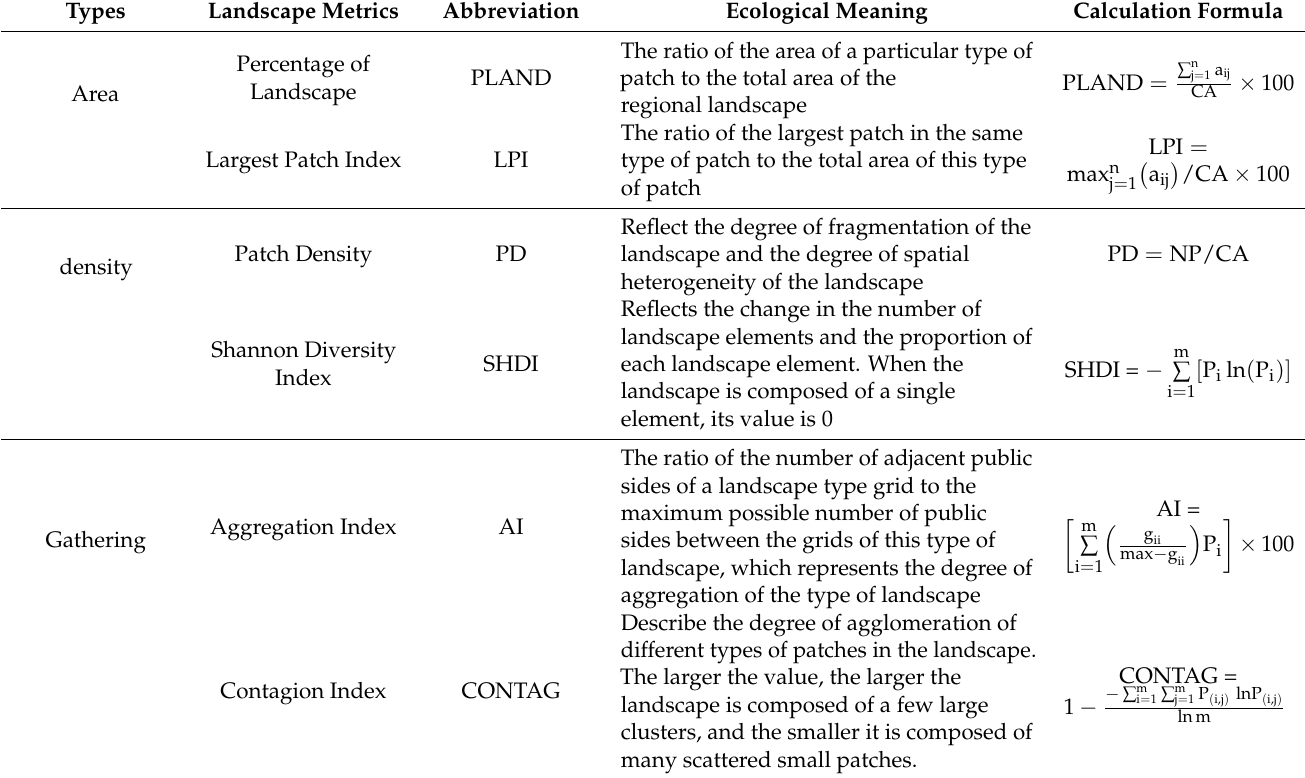
Table 2. The ecological implications and calculation formula of landscape